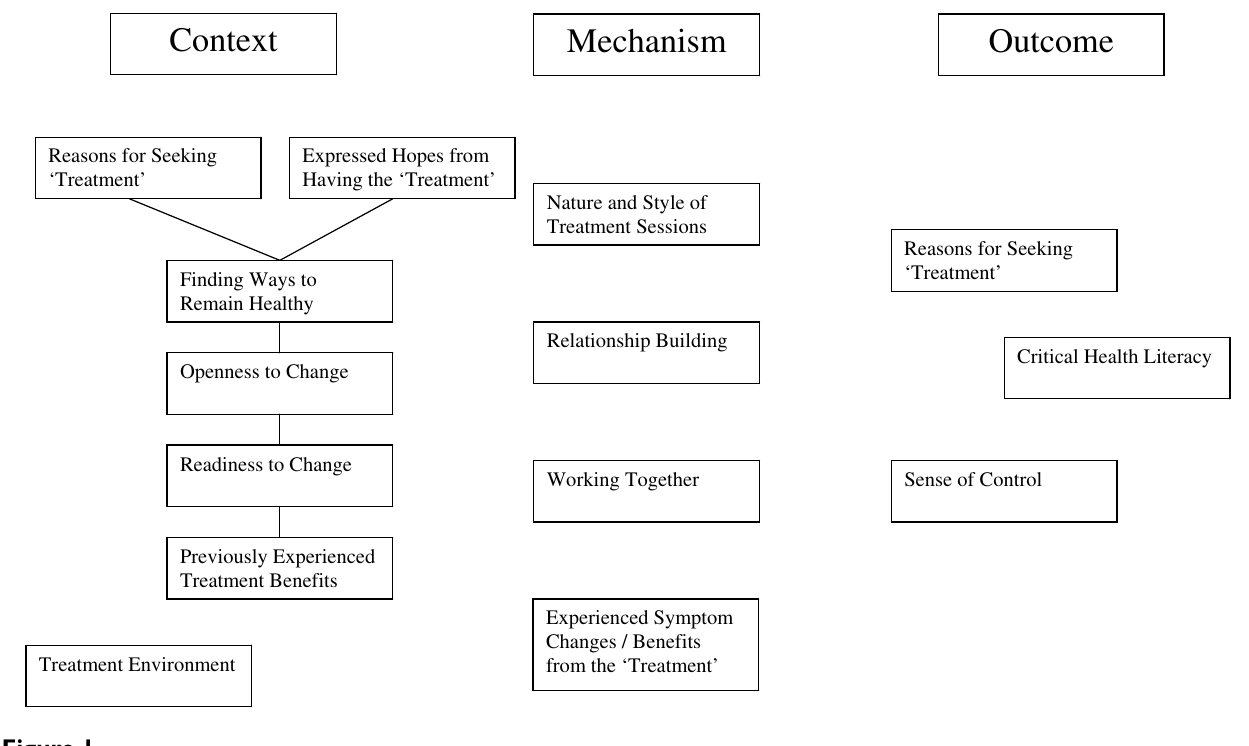
Figure 1 C-M-O Configuration for Critical Health Literacy